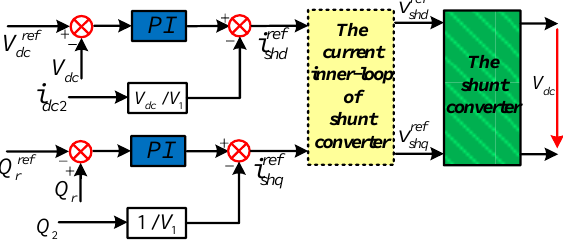
Figure 12. Diagram of the whole feedforward control scheme of the shunt converter.